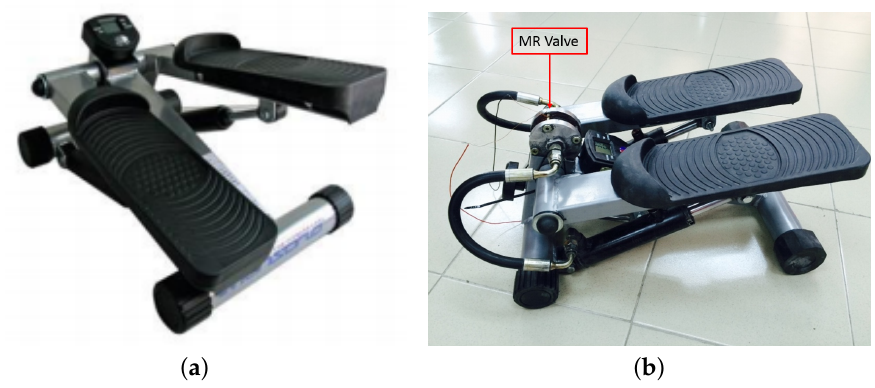
Figure 1. Conventional Stepper vs Modified stepper. ( a ) Conventional stepper; ( b ) Modified stepper (magnetorheological (MR)